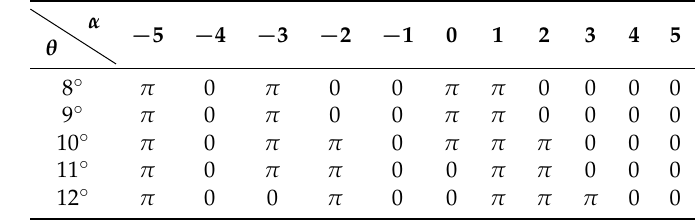
Table 1. Phase compensation for different modes and elevation angles with ka = 10 π